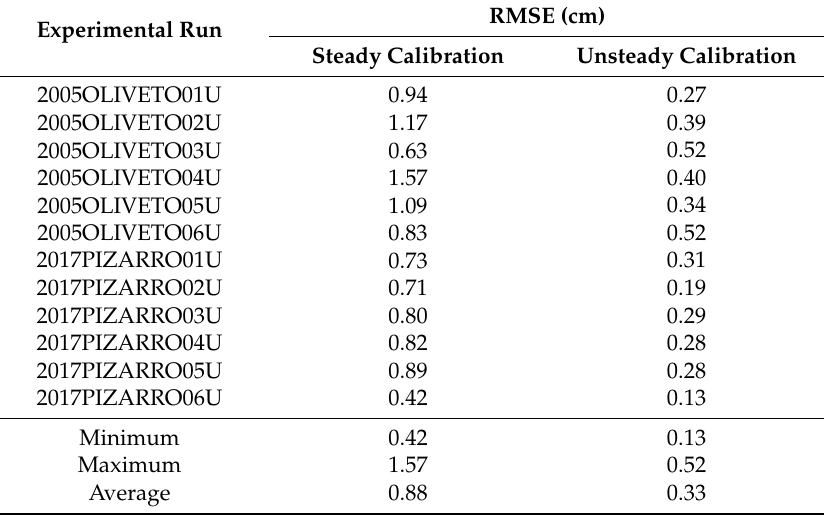
Table 3. Summary of model benchmarking in terms of RMSE.